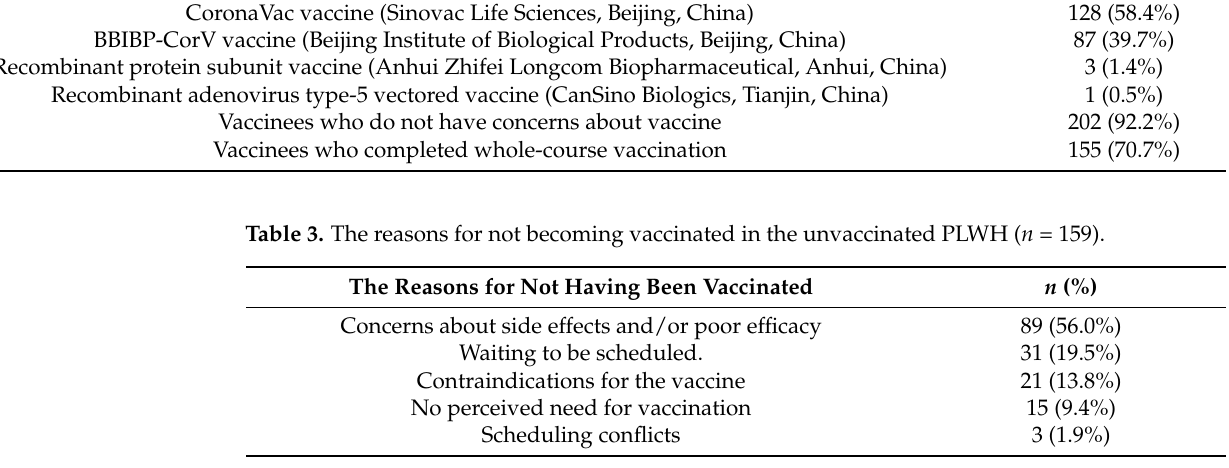
Table 2. COVID-19 vaccination statuses and attitudes toward the COVID-19 vaccine in the vaccinated PLWH ( n = 219). Patients Received at Least One Dose